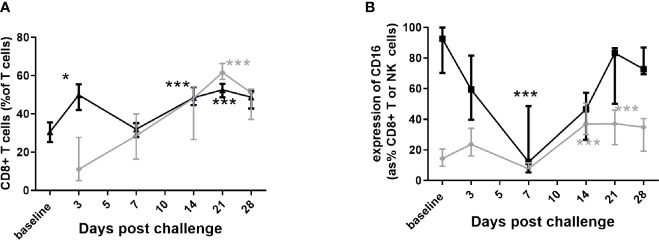
Changes in the lymphocyte populations in marmoset tissues following inhalational challenge with (C) burnetii. (A) changes in the CD8+ percentage of T cells in blood (black triangle) and lung (grey diamond), and (B) changes in CD16+ expression on CD8+ T cells (grey diamond) and on NK cells (CD3- CD56+ black square) in blood. Data is median and interquartile range, significance from baseline or Day 3 by ANOVA; * p<0.05, and ***p<0.001.